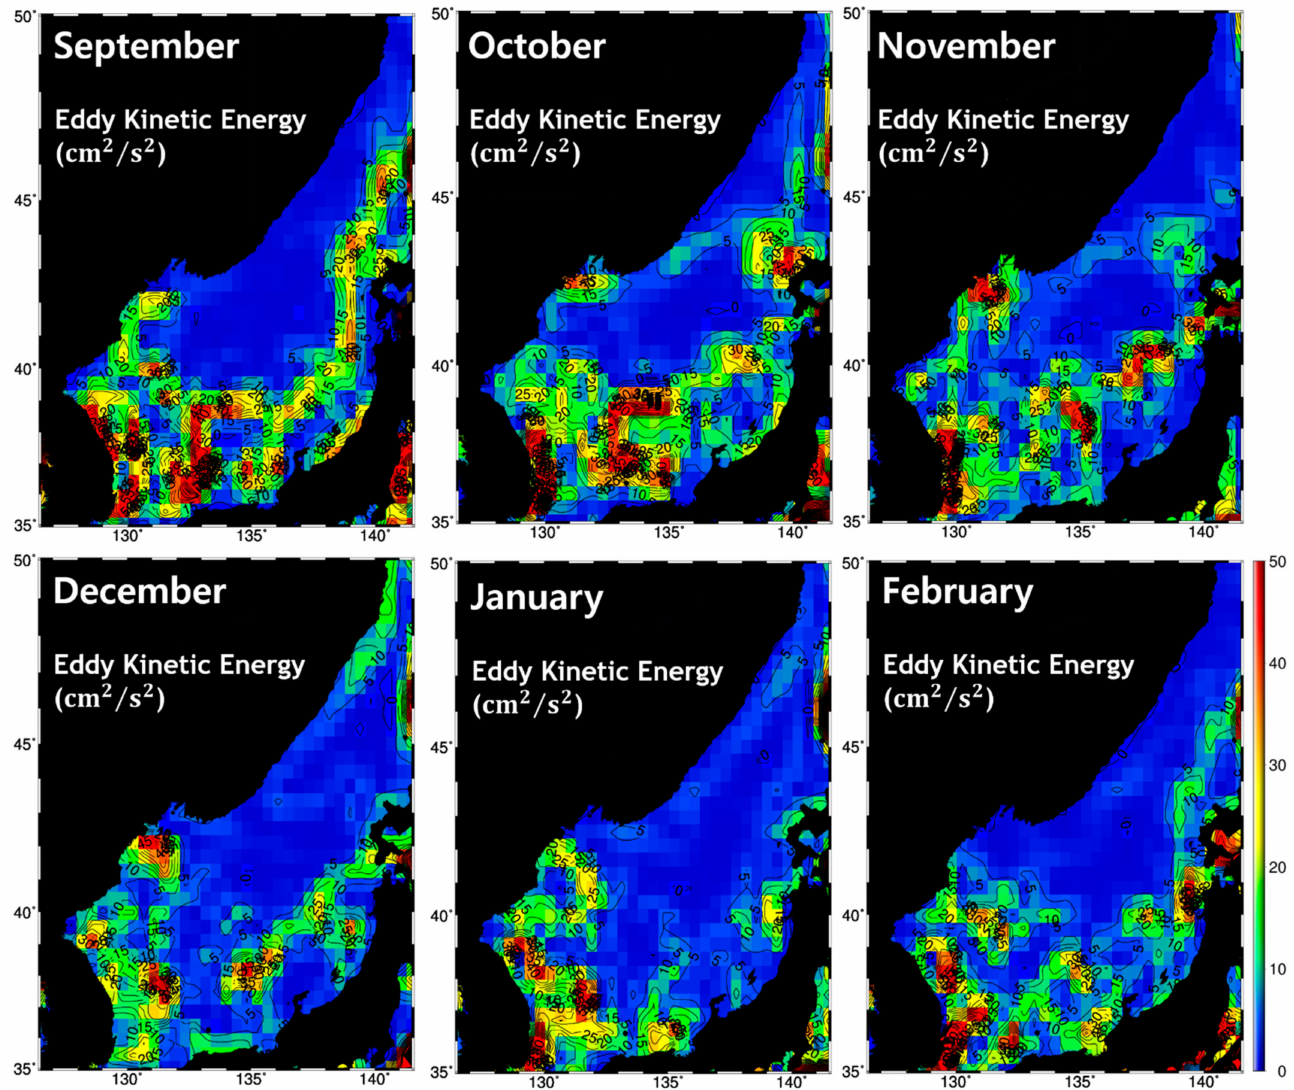
Figure A1. Horizontal distributions of climatological monthly mean eddy kinetic energy (cm 2 /s 2 ) in September—February averaged from 1993 through